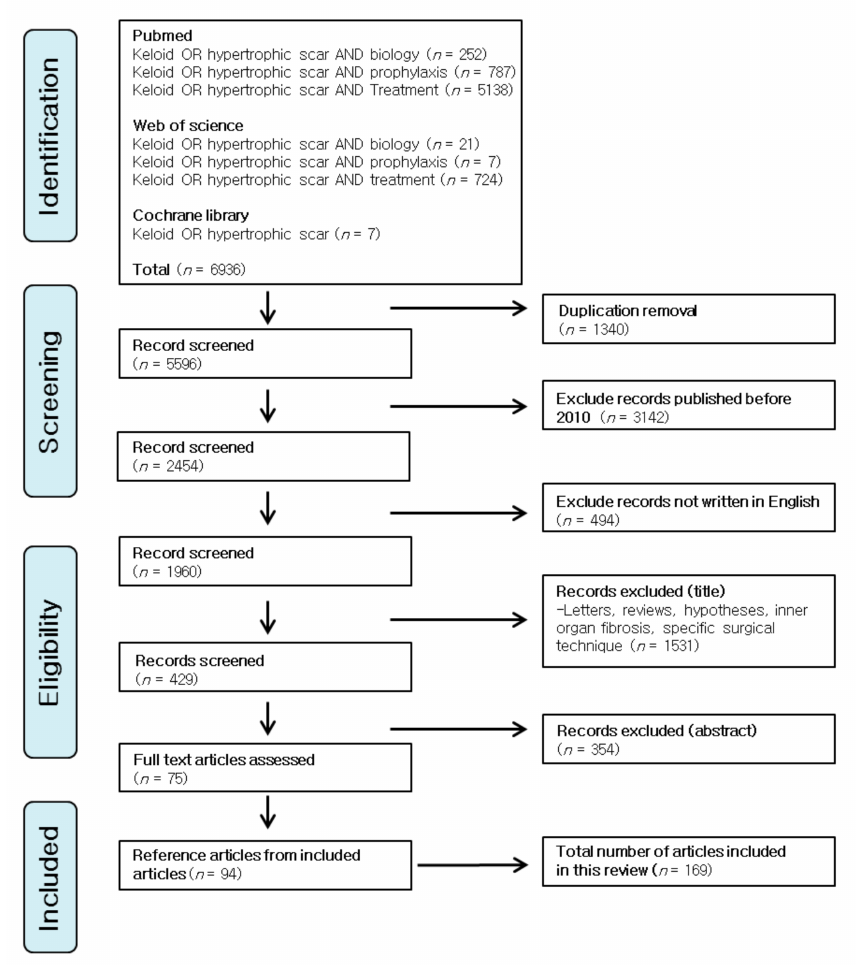
Figure 1. The flowchart of the literature search for this